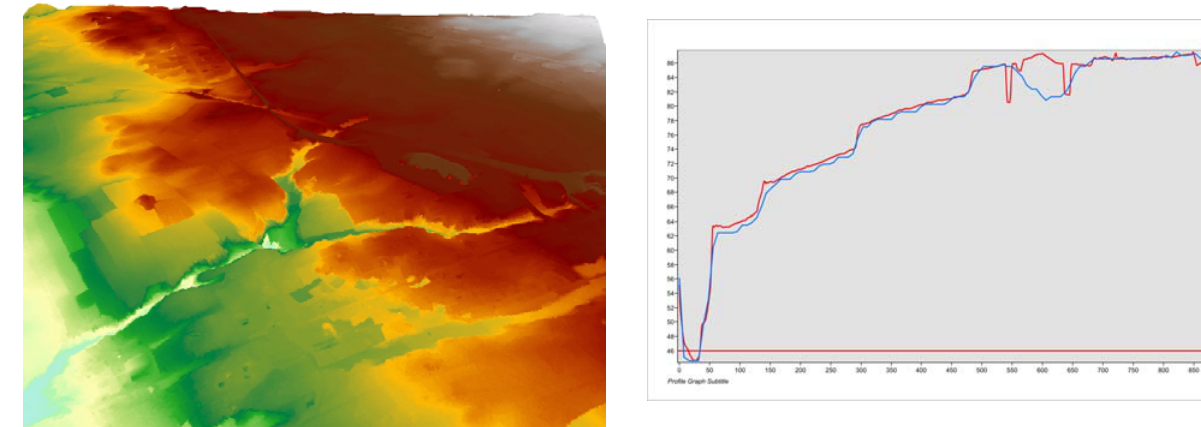
Figure 14. Comparison between profiles (test 2)